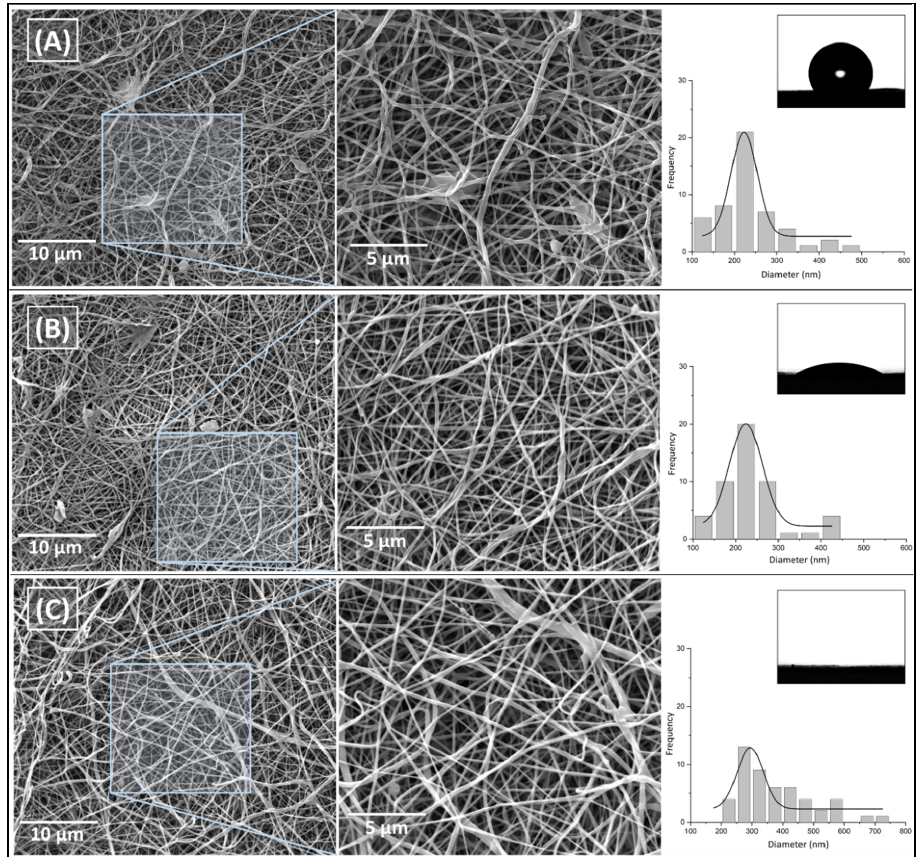
Figure 5. SEM images of electrospun mats with magnification variation and their histograms at varying concentrations of P. major extract in the relationship of PCL and the image of water drop on the surface of the mat that was taken during contact angle (CA) analysis. ( A ) PCL nano fi bers without extract (PCL_00%); ( B ) PCL nano fi bers with 5.3% of the extract (PCL_5.3%), and ( C ) PCL nano fi bers this 10.6% of the extract (PCL_10.6%).